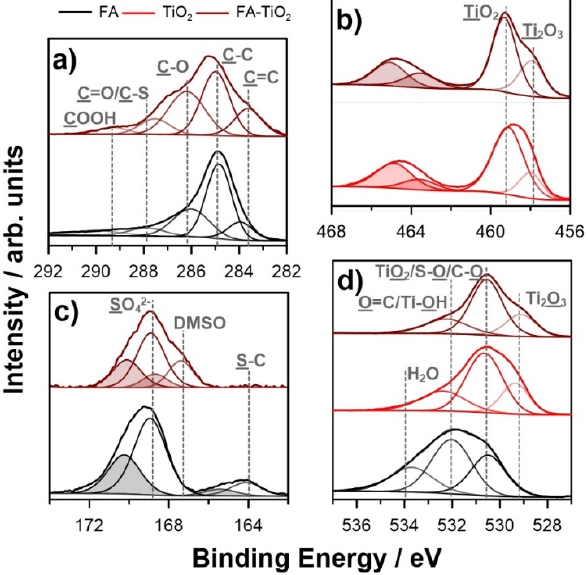
Figure 6. High-resolution XPS spectra in the core binding energy level of C 1s ( a ), Ti 2p ( b ), S 2p ( c ) and O 1s ( d ) for FA ( a , c , d ), bare TiO 2 ( b , d ) and FA-TiO 2 nanocomposite ( a – d ).